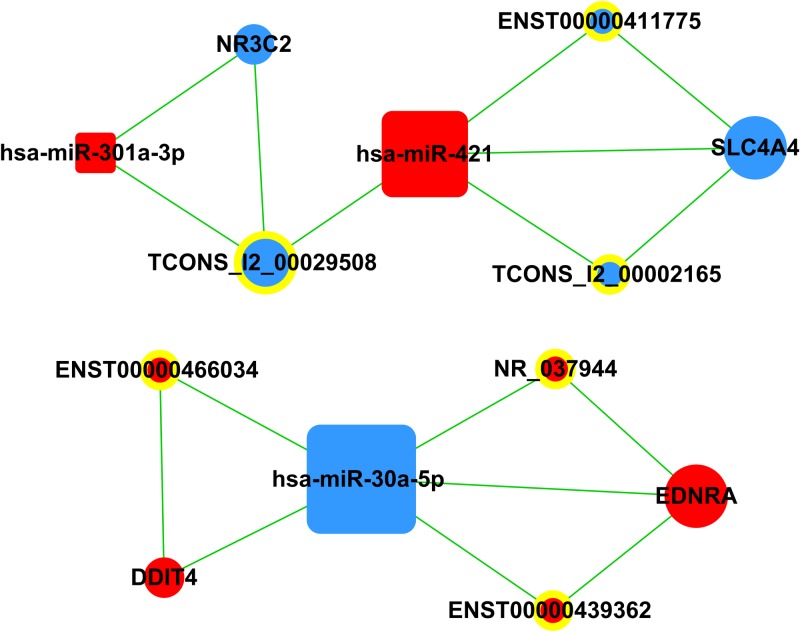
CeRNA network analysis of differentially expressed mRNAs, lncRNAs, and miRNAs in advanced LSCC.In the network, nodes represent mRNAs, nodes with yellow rings represent lncRNAs, squares represent miRNAs, and the size of the node’s area represents the value of betweenness centrality. Red color indicates up-regulation, blue color indicates down-regulation, and edges indicate target interactions.